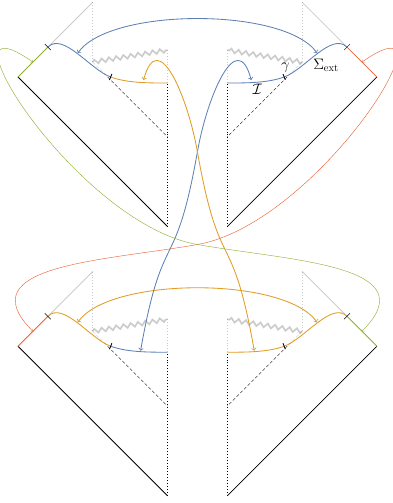
(a) The ‘trivial’ geometry with the boundary conditions appropriate for the swap operator same boundary conditions, obtained from (a) by changing the identifications along the ‘is- land’ I . Figure 15. Two geometries in the path integral contributing to the expectation value of the swap operator acting on I u for two sets of Hawking radiation. The right spacetime is an n = 2 replica wormhole. To obtain this, we divide the partial Cauchy surface Σ u into two pieces I and Σ ext along the codimension-2 surface γ . The connections along Σ ext are the same as in (a), but are swapped along the island I . The configuration shown is not a saddle as it does not incorporate back-reaction from the structure near the special surface γ , and incorporating such back-reaction will make the spacetime metric complex. That is, passing the contour of integration through the desired saddle requires deforming it away from real Lorentzian metrics. However, the replica wormhole saddle will coincide with the (real) Hawking saddle in the formal limit n → 1 of the replica number n